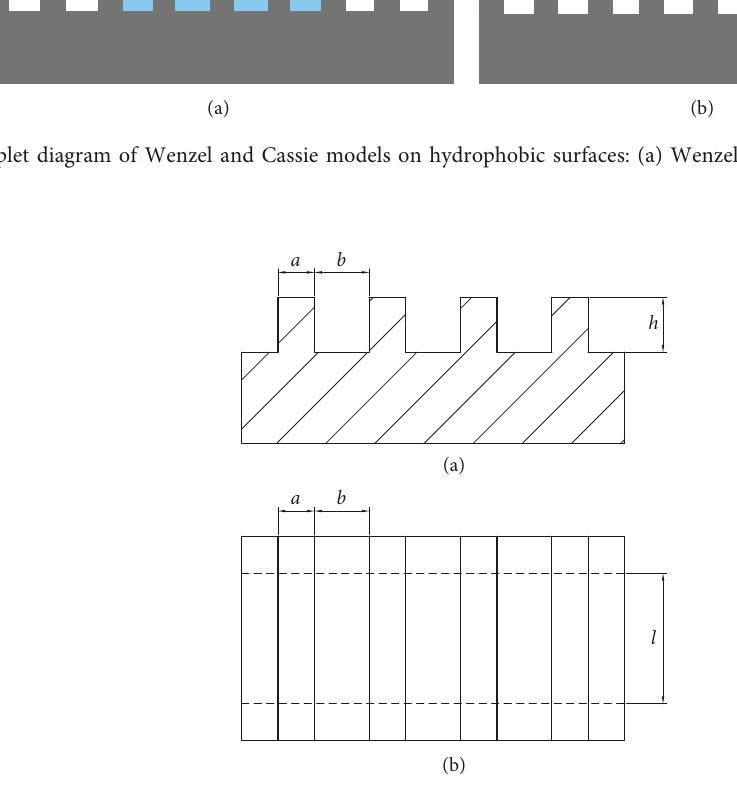
Figure 3: The diagram of the structural parameter of the grating structure.